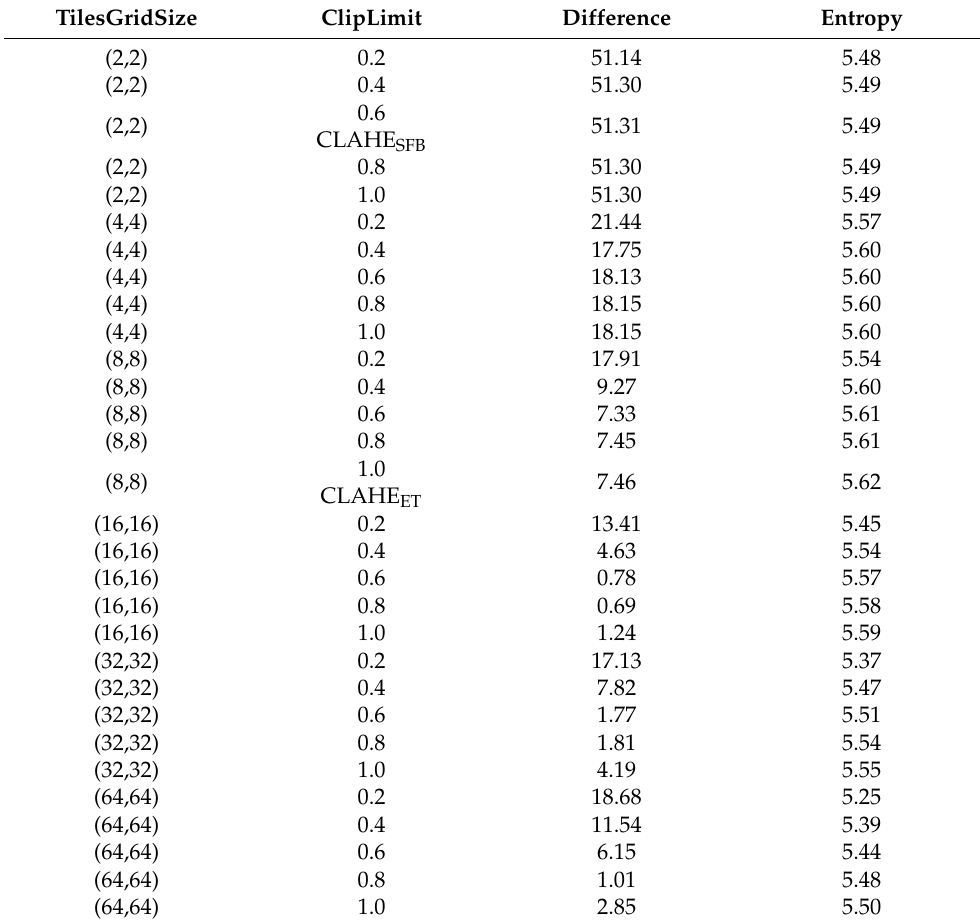
Table 2. Comparison of difference and entropy values for each combination of CLAHE parameters.